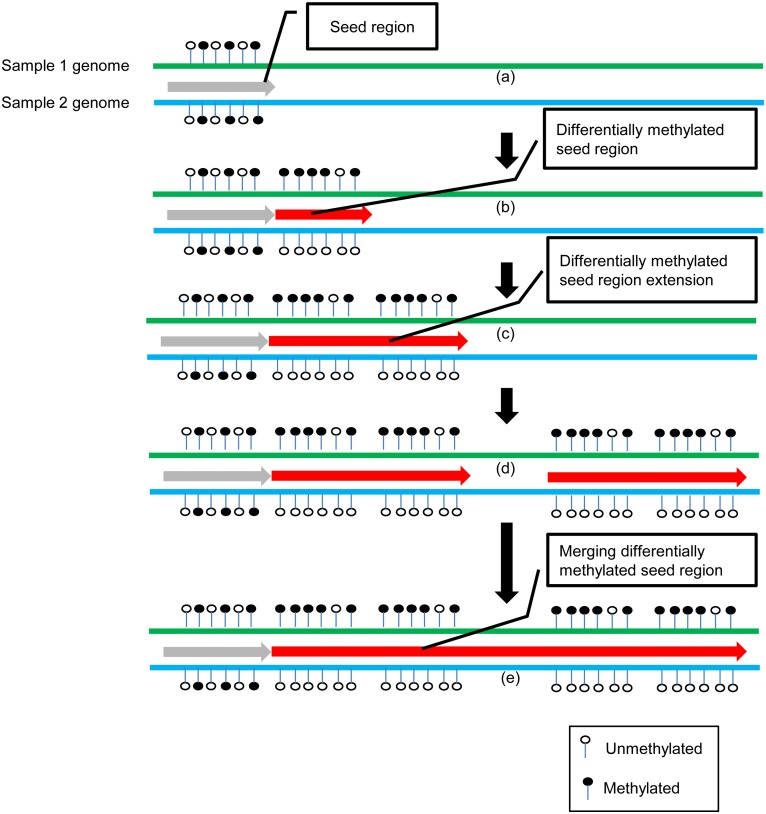
Principle of DMR detection by BSAnalyzer.(A) Firstly, starting from one end of the genome to search for a seed region (i.e., 500 bps) using a sliding window. (B) If the seed region is located, Mann-Whitney test will be used to test if the seed region is a differentially methylated seed region. (C) Two adjacent differentially methylated seed regions are merged into one extended seed region (seed region extension). (D) Two discontinued differentially methylated regions are further merged together if they are within a certain distance (e.g. less than 1000 bps) for further differential methylation test using χ2 test.